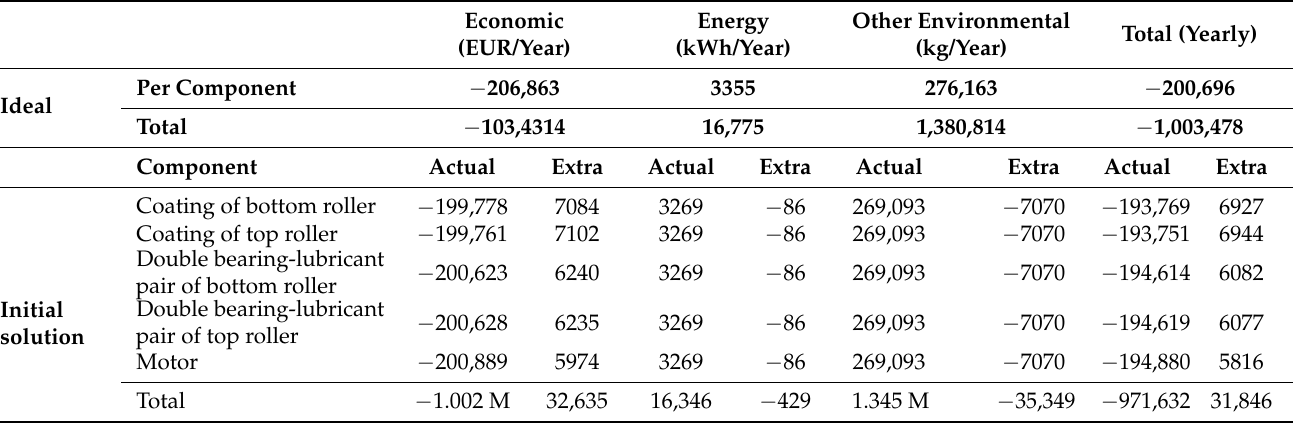
Table 21. KPIs yielded from training the model with paired coated rollers for the bleaching machine